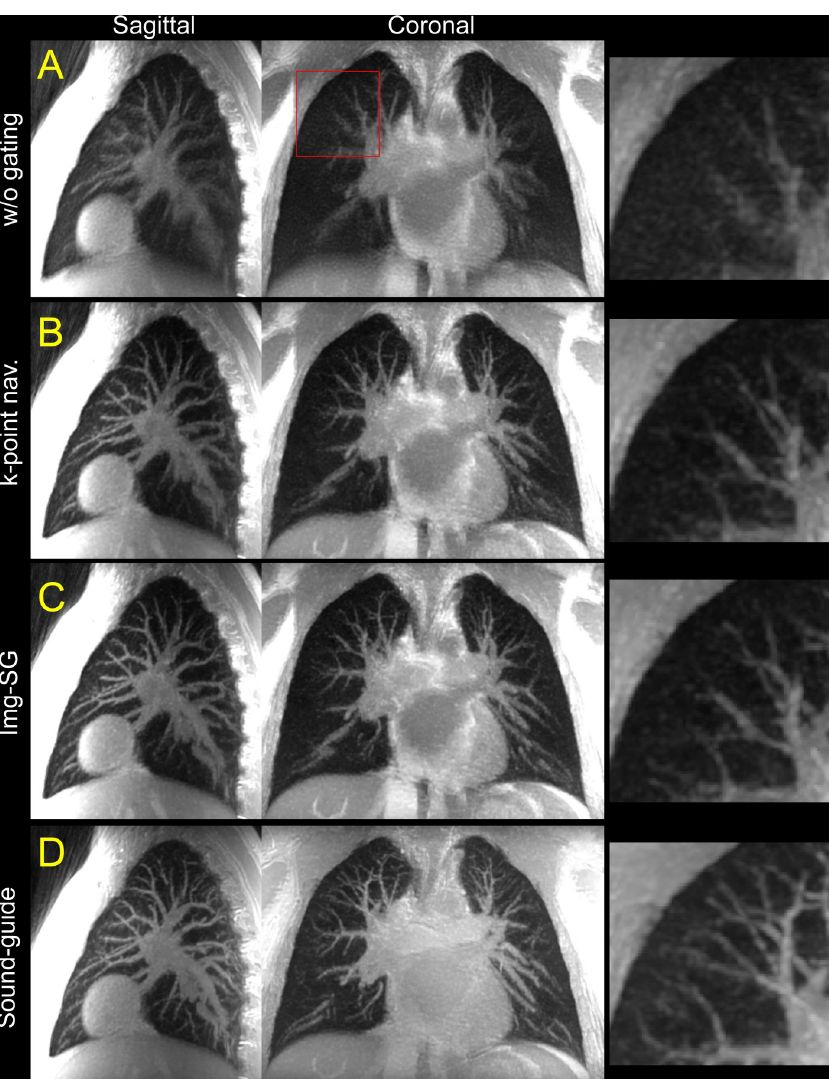
Fig 6. Maximum intensity projection (MIP) of high-resolution UTE MRI images. MIP images for free-breathing without respiratory motion management (w/o gating, A) and free-breathing with retrospective respiratory gating (k- point navigator, B, or image-based self-gating [Img-SG], C), and sound-guided respiration (Sound-guide, D) are presented in sagittal (left) and coronal (center) views. Images obtained with respiratory motion management (B-D) clearly show improved delineation of pulmonary vasculature as compared to w/o gating (A). Moreover, the MIP image from Sound-guide shows notably better visualization for peripheral blood vessels in zoomed views as compared to k- point navigator and Img-SG (right). The MIP images were computed from a 2.1-cm thick slab for both sagittal and coronal views. The images shown in this figure are from the same subject as the one in Figs 2–5. Coronal MIP images with a projection slab sliding from posterior to anterior are shown in S1